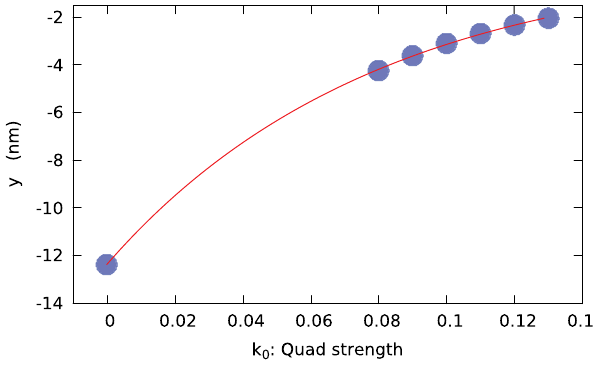
FIG. 6. The average vertical beam offset vs the magnetic quadrupole strength in units of T/m with alternating sign quadru- poles. In addition to the magnetic focusing there is also electric ¼ 0 . 1 , with Q focusing with a field index of m ¼ Q 2 the vertical y y tune when there is only electric focusing. The radial B-field ¼ 1 pT, and N ¼ 0 for its harmonic value around applied is B r the ring. The vertical offset does not go to zero for zero magnetic focusing due to the presence of the electric